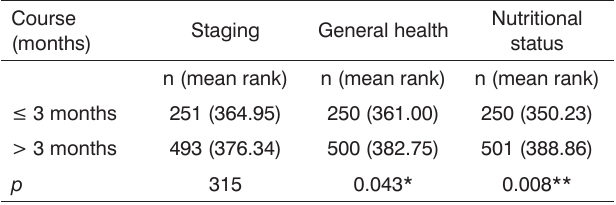
Table 5. Descriptive measure (mean rank) of disease course according to staging, patient's general condition and nutritional status, and the Mann-Whitney